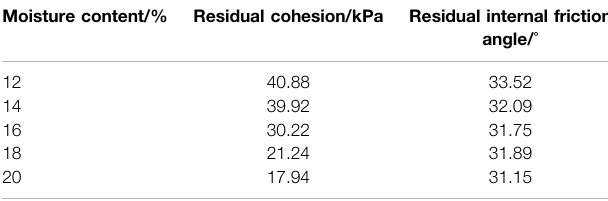
TABLE 3 | Residual shear strength parameters under different moisture content.